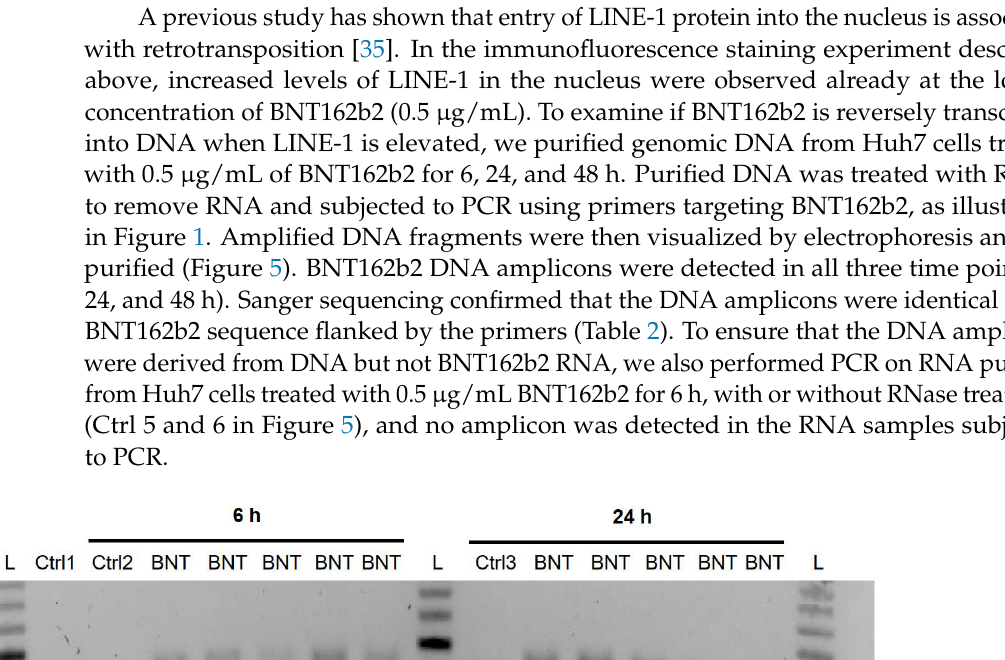
Table 2. Sanger sequencing result of the BNT162b2 amplicon.